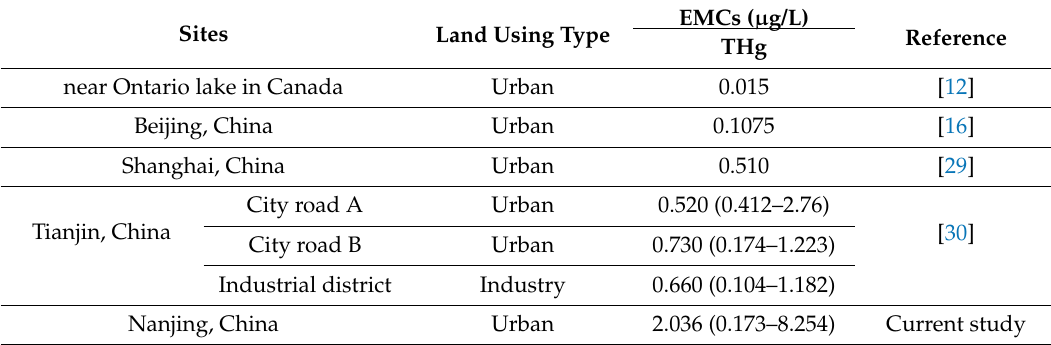
Table 5. EMCs of Hg pollution in different regions (average